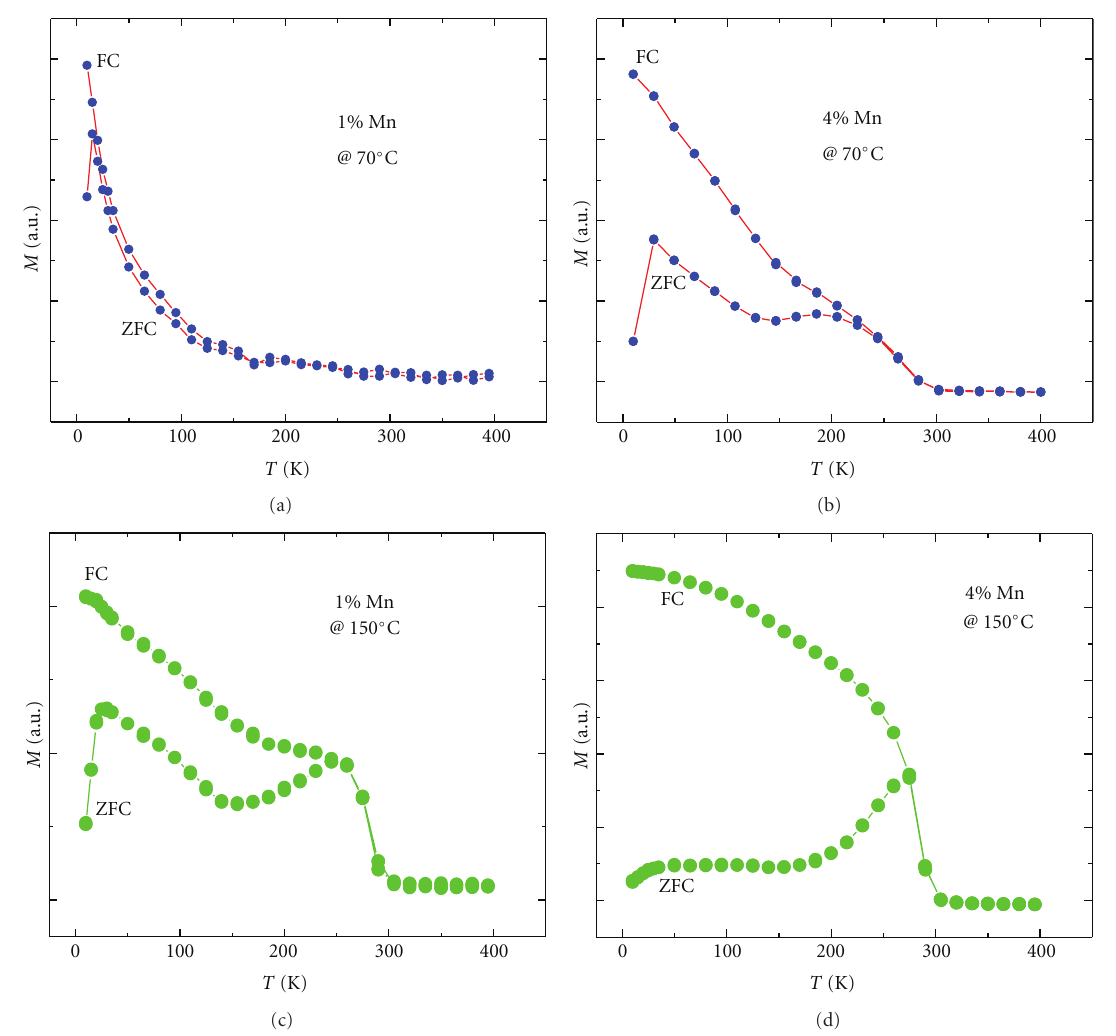
Figure 11: ZFC and FC curves measured with a magnetic field of 200 Oe for Ge 1 − x Mn x samples. (a) x = 1%, grown at 70 ◦ C, (b) x = 4%, grown at 70 ◦ C, (c) x = 1%, grown at 150 ◦ C, (d) x = 4%, grown at 150 ◦ C. Reproduced from [16]. Copyright ©2010, Elsevier